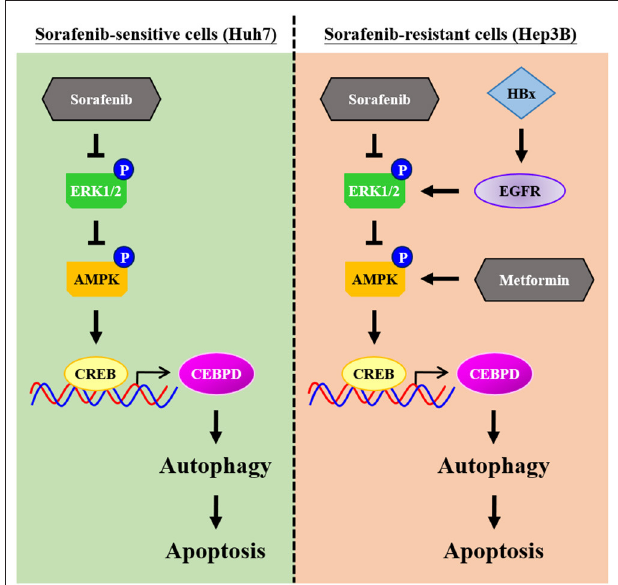
FIGURE 7 | Schematic model of the molecular mechanism by which metformin increases the sensitivity of Hep3B cells to sorafenib. Hep3B cells are intrinsically more resistant than Huh7 cells to sorafenib. High activity of epidermal growth factor receptor (EGFR) and low autophagic responsiveness may determine the primary resistance of Hep3B cells to sorafenib. CCAAT/enhancer binding protein delta (CEBPD), a potent tumor suppressor, is responsive to metformin via AMP-activated protein kinase (AMPK) activation, and it promotes autophagic cell death. Furthermore, metformin can resensitize sorafenib-induced autophagic cell death in Hep3B cells. Taken together, our results provide possible implications for improving the efficacy of sorafenib and helping to develop personalized medicine strategies for HCC